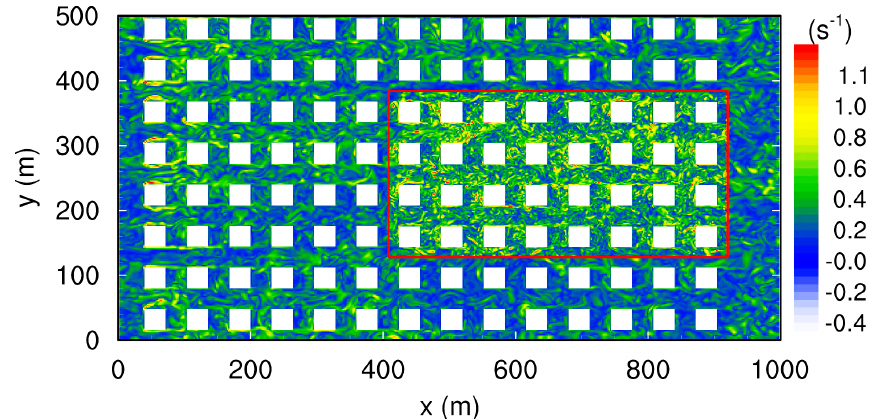
Figure 4. Instantaneous horizontal cross section of the absolute value of the vorticity vector at a height of 10m for a two-way LES–LES nested simulation of the turbulent flow around an array of cube-shaped buildings. The parent domain has a grid spacing of 2m and the child domain (indicated by the red box) has a grid spacing of 1m. The mean flow is parallel to the x axis from left to